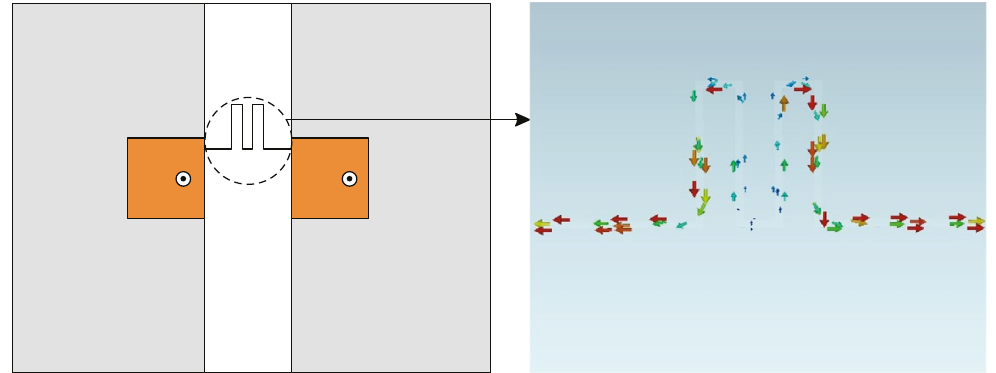
Figure 4: The antenna array with the ML in the fi rst con fi guration and the current distribution of the ML.